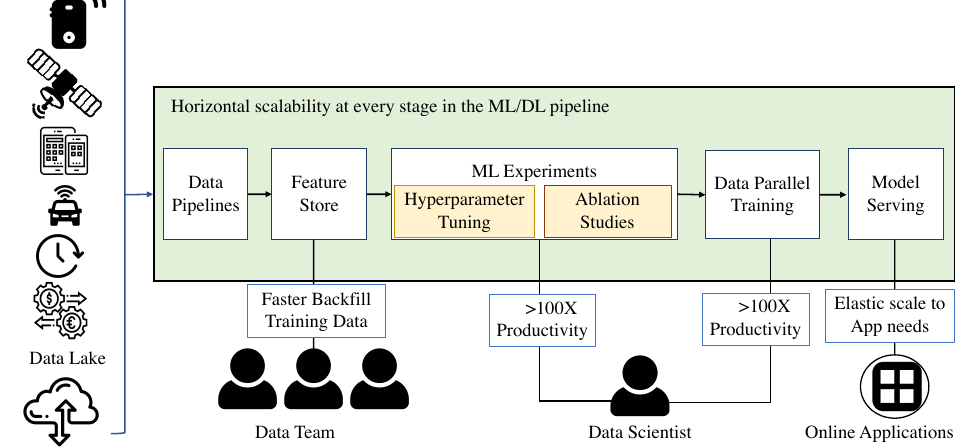
Figure 4. Data ingestion sources for an ML/DL pipeline for EO data in the Hopsworks platform